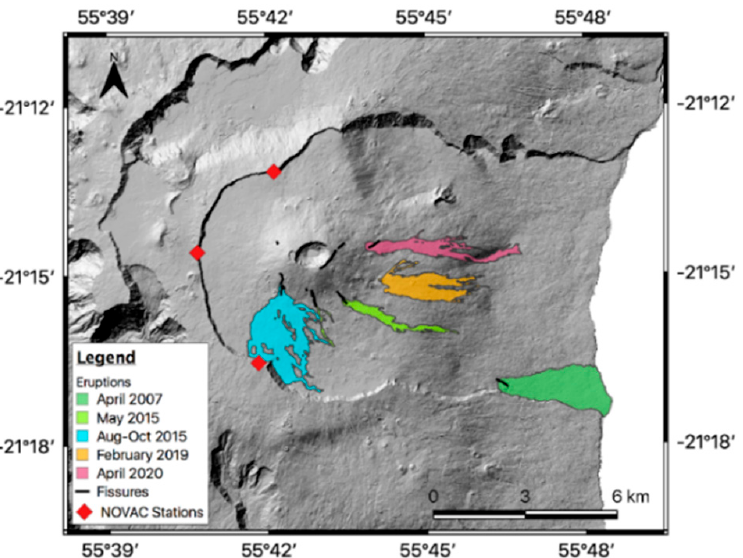
Figure 1. Map of Piton de la Fournaise showing the location of the three DOAS stations of the NOVAC network, and the position of the eruption vents and lava flow fields studied here. The background is the hill shaded relief from the 2016 Digital Elevation Model (DEM) produced in April 2016 from optical Pl é iades satellite images acquired in stereo triplet mode and processed by the French Centre National d’Etudes Spatiales using their S2P restitution code [16]. The lava flow outlines and fissure locations are from Chevrel et al. (2021) [17] and OVPF reports ISSN 2610-5101.